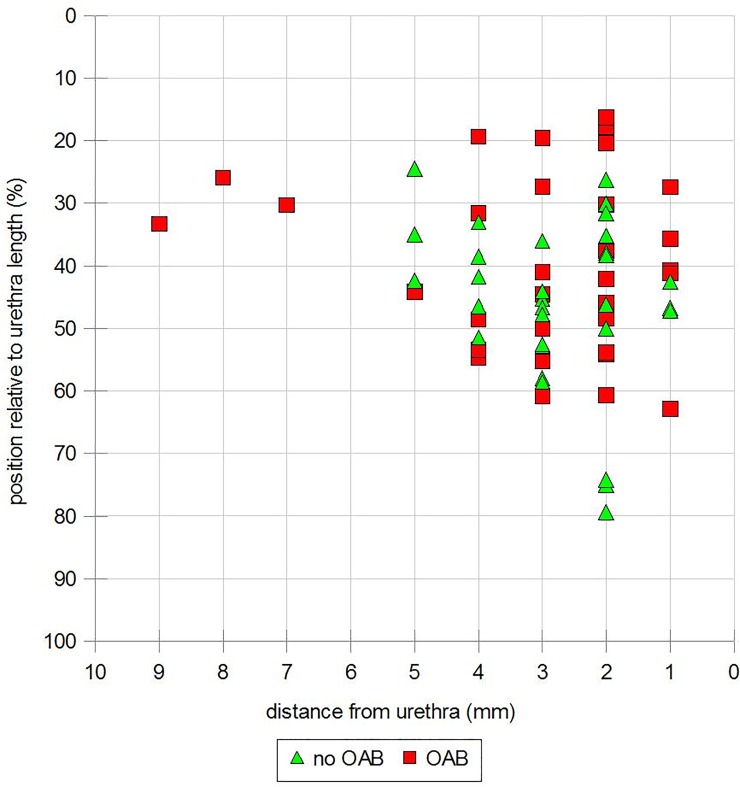
Outcome of women with or without OAB symptoms dependent on tape position relative to TUD and TP.